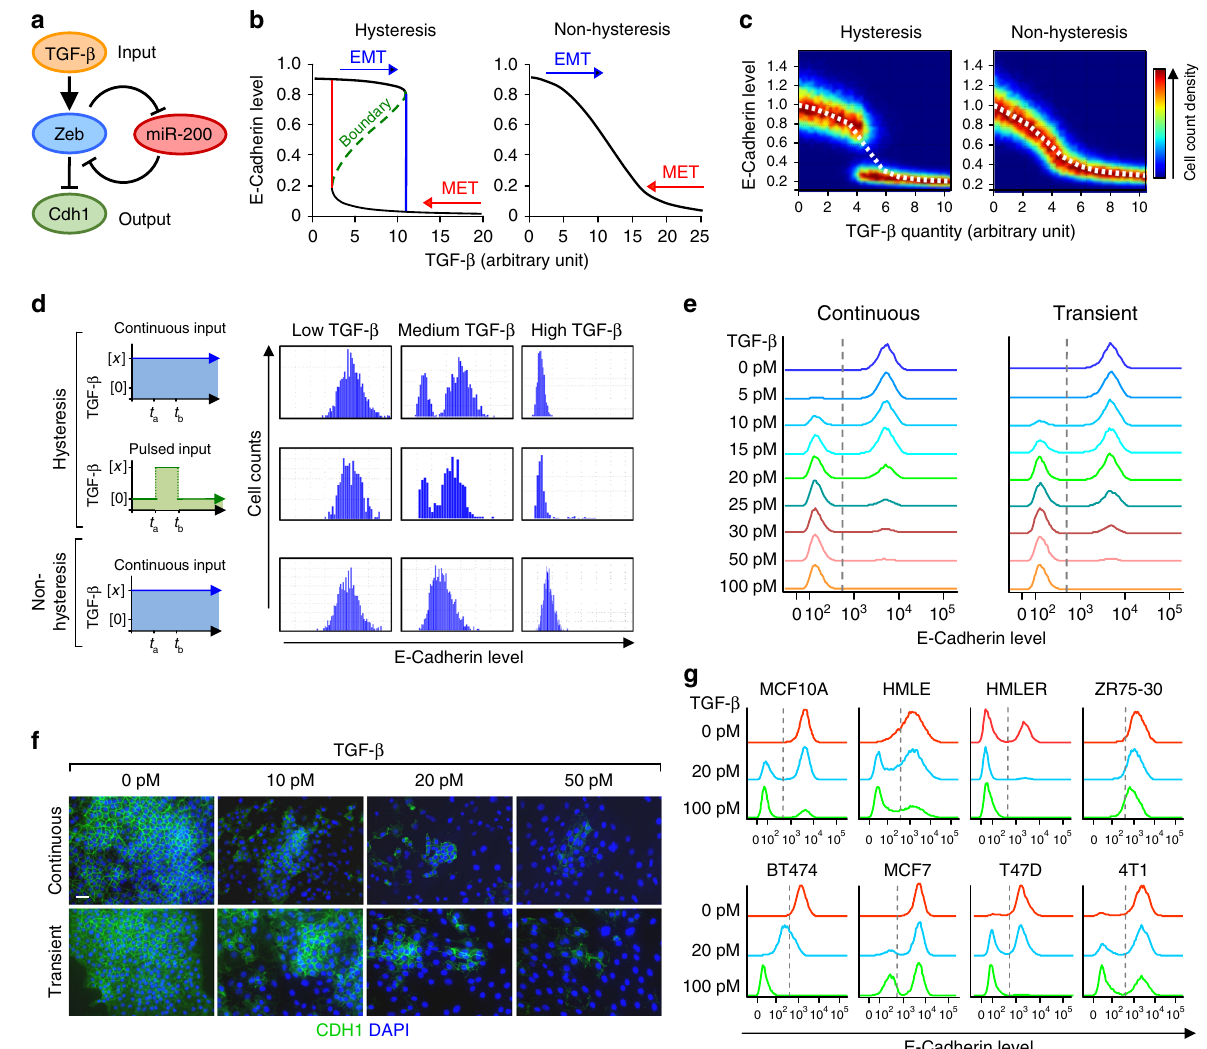
Fig. 1 Mathematical modeling and experimental validation of mammary epithelial cells undergoing EMT. a Diagram of the simpli fi ed model of TGF- β induced EMT and the central role of the miR-200-Zeb double negative feedback loop. b Hysteresis within EMT and MET as indicated by CDH1 expression level (left panel) and altered model (non-hysteresis, right panel), based on ODE single cell deterministic model. Within a certain range of TGF- β (2.5-12 arbitrary unit), the steady-state CDH1 level is bistable and is either high or low, depending on the previous state of the cells (i.e. whether it is undergoing EMT or MET). c Simulated steady-state calculations of CDH1 level in a homogeneous collection of cells in increasing dose of TGF- β . Heatmap graphs depict CDH1 expression at single cell level (color indicates cell count for a given CDH1 expression level) and the dashed line represents CDH1 expression as the average of the population. Note the bistable shift in the hysteresis model (left) versus the gradual shift in the non-hysteresis model (right). d Computational simulation of CDH1 expression after different regimes of TGF- β treatment in a cell population. e Flow cytometry analysis and f Immuno fl uorescence of the endogenous CDH1 expression in parental NMuMG cells after treatment with indicated concentrations of TGF- β for 72 h (histograms, left), or for just 1 h of transient treatment, followed by measurement of CDH1 expression 72 h later (histograms, right). g Flow cytometry analysis of CDH1 expression in multiple normal and cancerous mammary epithelial cell lines after 100 pM TGF- β treatment for 9 days. Scale bar: 20 μ m in